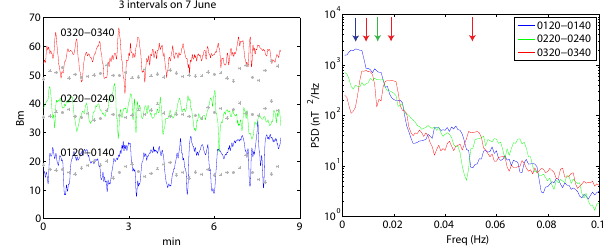
Figure 10. Left: zoom in on interval 19:10–19:12UT, the MIP elec- tron density is following B m , fil (blue) in the first minute. Just after 19:11UT the MIP is almost in anti-phase with the non-filtered B m (cyan) for about 30s. Right: zoom in on interval 01:21–01:40UT showing that the LAP P1 current (red) is in anti-phase with B m .